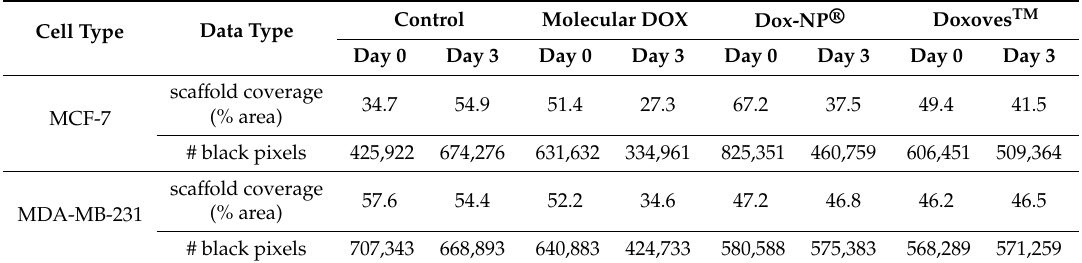
Table 2. Quantification results (%) for spheroid area coverage by cells corresponding to Figure 5A binary processed images of MCF-7 and MDA-MB-231. Results tabulated for pre- (Day 0) and post- (Day 3) treatment with DOX, Dox-NP ® , and Doxoves TM drug